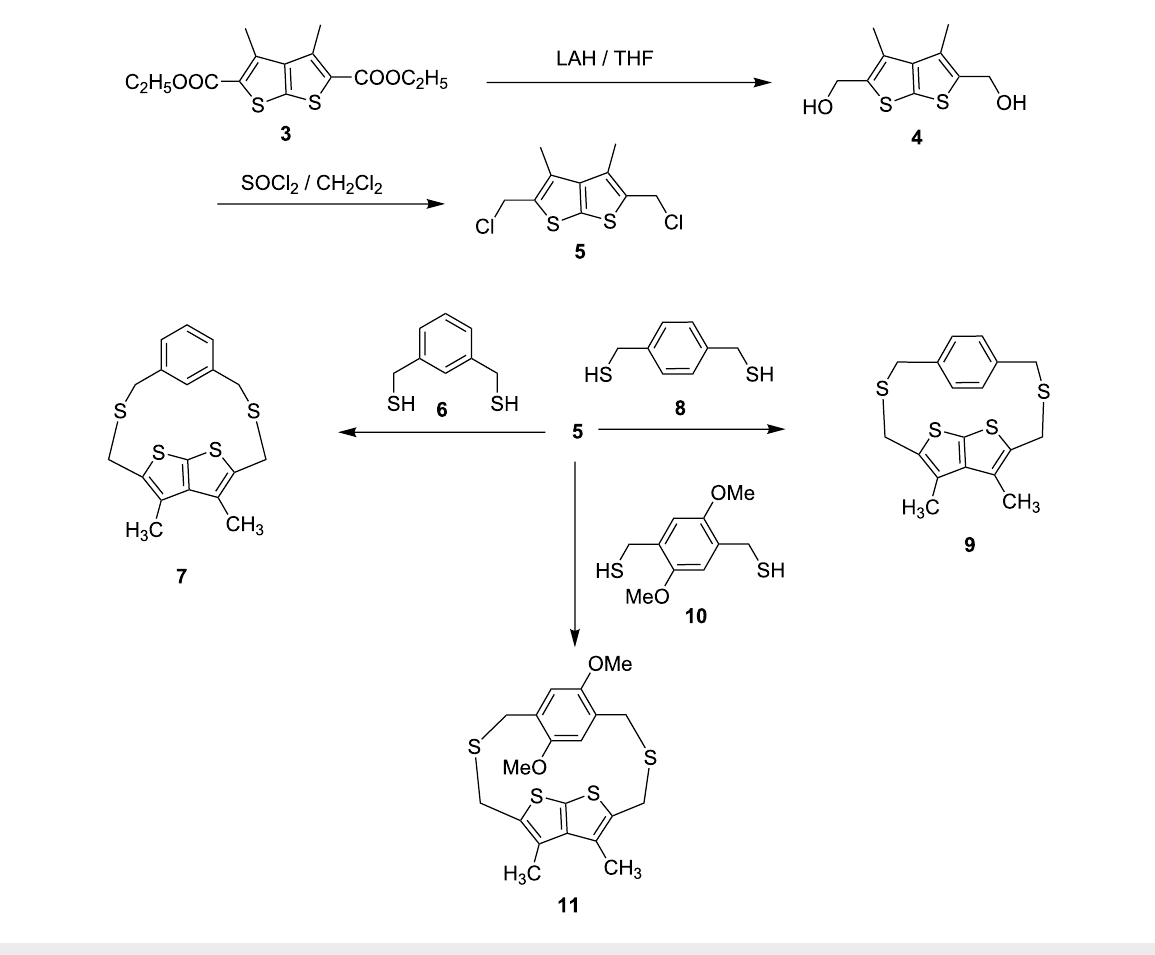
Scheme 1: Synthetic scheme for compounds 7 , 9 and 11